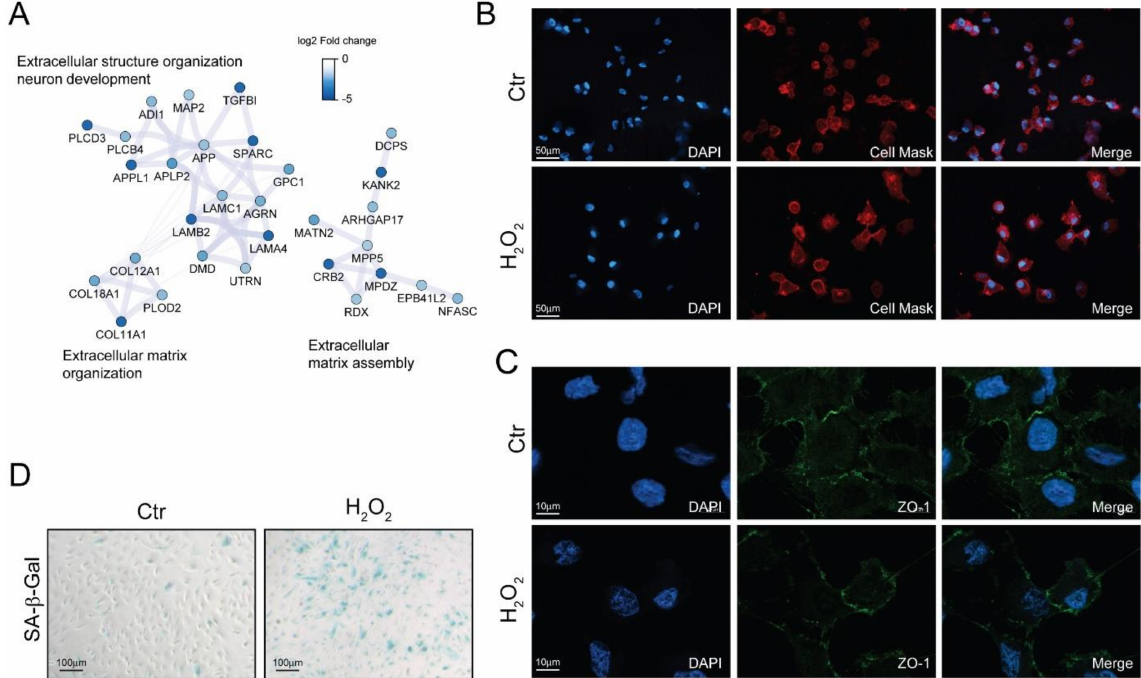
Figure 4. Chronic sublethal oxidative insult induces senescence in ARPE-19 cells. ( A ) Selected networks of proteins showing down-regulation in H 2 O 2 -treated cells and involved in extracellular matrix organization and assembly. Node color is related to the log2 fold change difference in expression between H 2 O 2 and Ctr. Ctr and H 2 O 2 treated cells were seeded on coverslips H 2 O 2 -free medium and grown in for 72 h before processing; ( B ) Morphological changes of plasma membranes in live cells assessed by CellMask Red staining; magnification 20 × ; ( C ) Expression and distribution of ZO-1 determined by immunofluorescence analysis. Magnification 100 × ; ( D ) SA- β -Gal activity assay. Senescent cells are stained in blue, magnification 10 × . In ( B – D ) the images are representative of one out of three separate